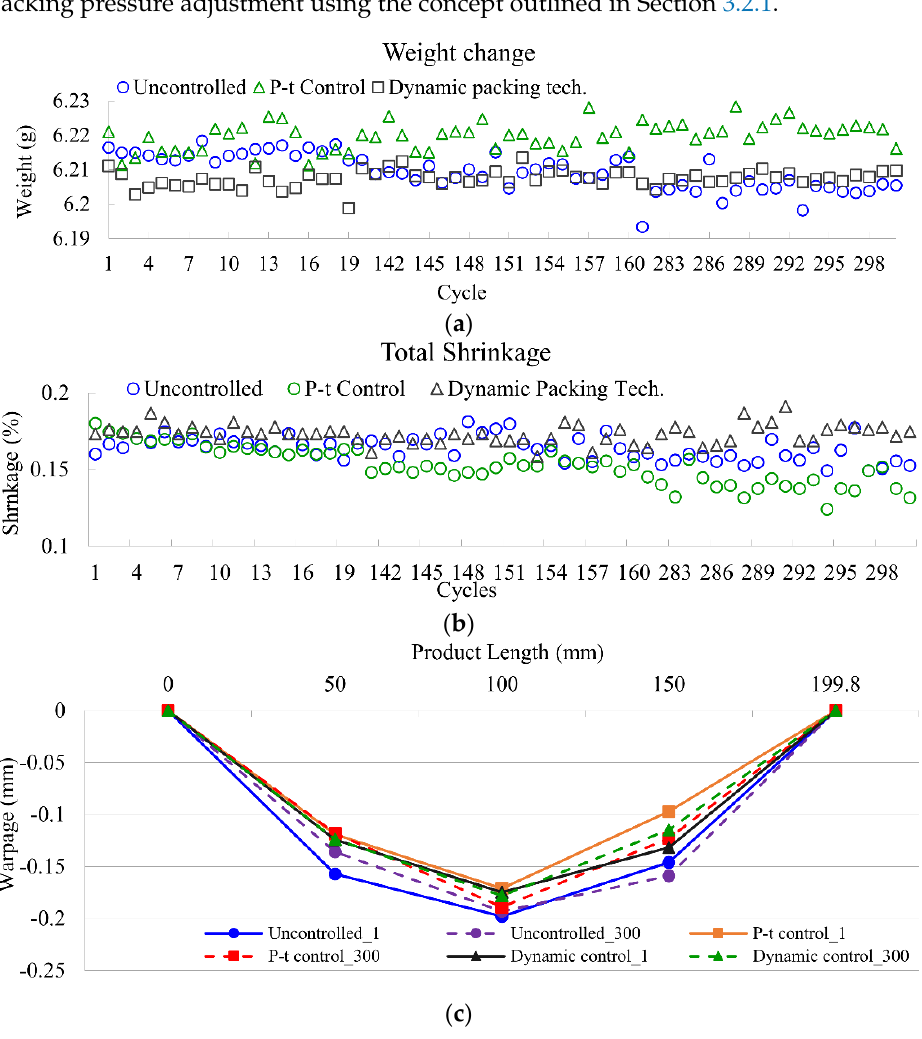
Figure 17. The results for ( a ) product weight, ( b ) total shrinkage, and ( c ) warpage for three control methods.